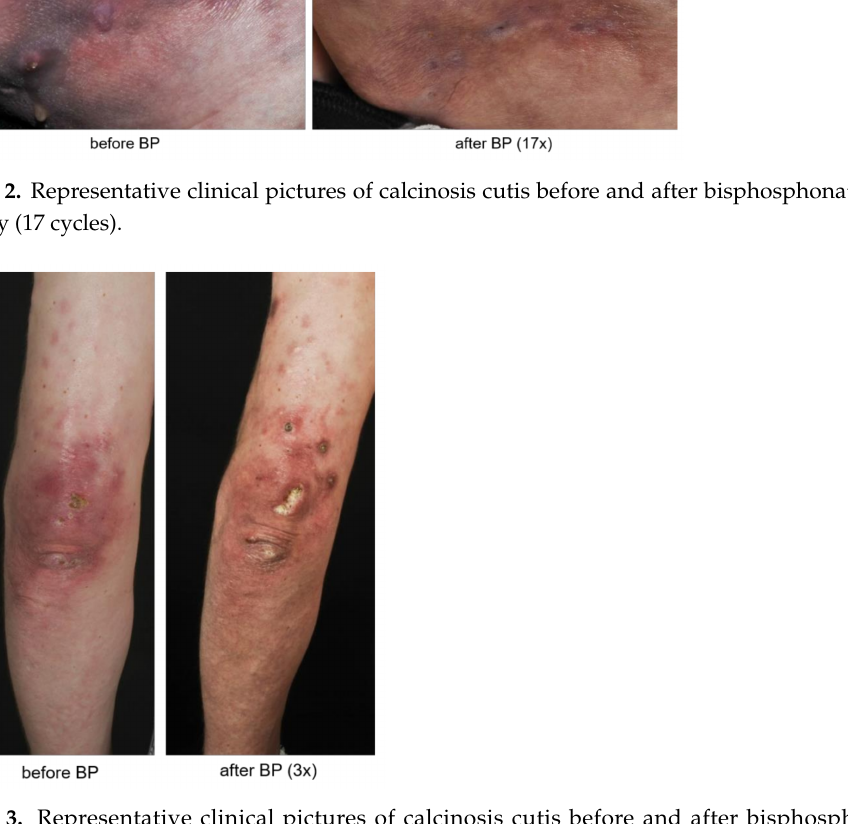
Figure 3. Representative clinical pictures of calcinosis cutis before and after bisphosphonate (BP)